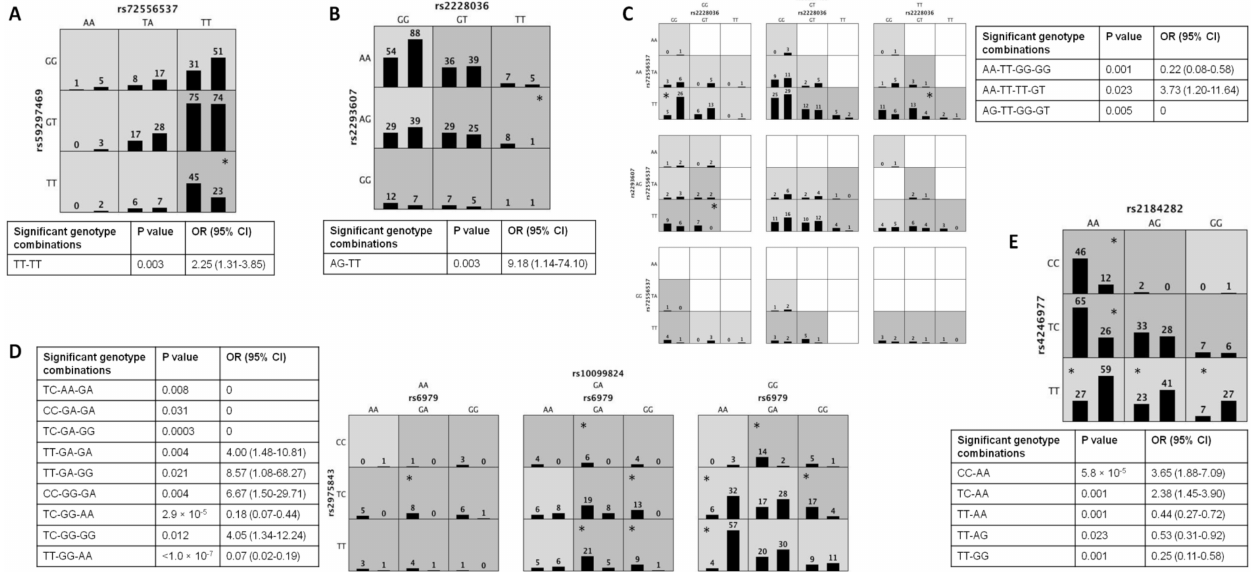
Figure 3. MDR generated distribution of genotype interactions in observed best models. In the Figure, sub-figures ( A – C ) represent a comparison of the two to four loci genotype interactions between the HAPE patients and HAPE-free controls. In sub-figures ( D , E ), two to three loci genotype interactions are compared between the two control groups, i.e., HAPE-f (HAPE-free healthy controls) and HLs (high-land natives). ( A ) HAPE-associating shelterin genes in a 2-locus best model. The TT-TT ( TPP1/ACD rs72556537A/T- RAP1/TERF2IP rs59297469G/T) interaction was observed as risk in which the protective allele TPP1 rs72556537A was absent. ( B ) HAPE-associating telomerase genes in a 2-locus best model. A risk-predicting TT-AG ( TEP1 rs2228036G/T- TERC rs2293607A/G) interaction was observed in which risk allele TEP1 rs2228036T was present as homozygous genotype TEP1 rs2228036TT and risk allele TERC rs2293607G was present as heterozygous rs2293607AG genotype. ( C ) HAPE-associating genes of the telomere-telomerase system in a 4-locus best model. The TT- GT-AA-TT ( RAP1 rs59297469G/T- TEP1 rs2228036G/T- TERC rs2293607A/G- TPP1 rs72556537A/T) risk-predicting interaction consisted of risk allele RAP1 rs59297469T as homozygous rs59297469TT genotype and risk allele TEP1 rs2228036T as heterozygous rs2228036GT genotype. The